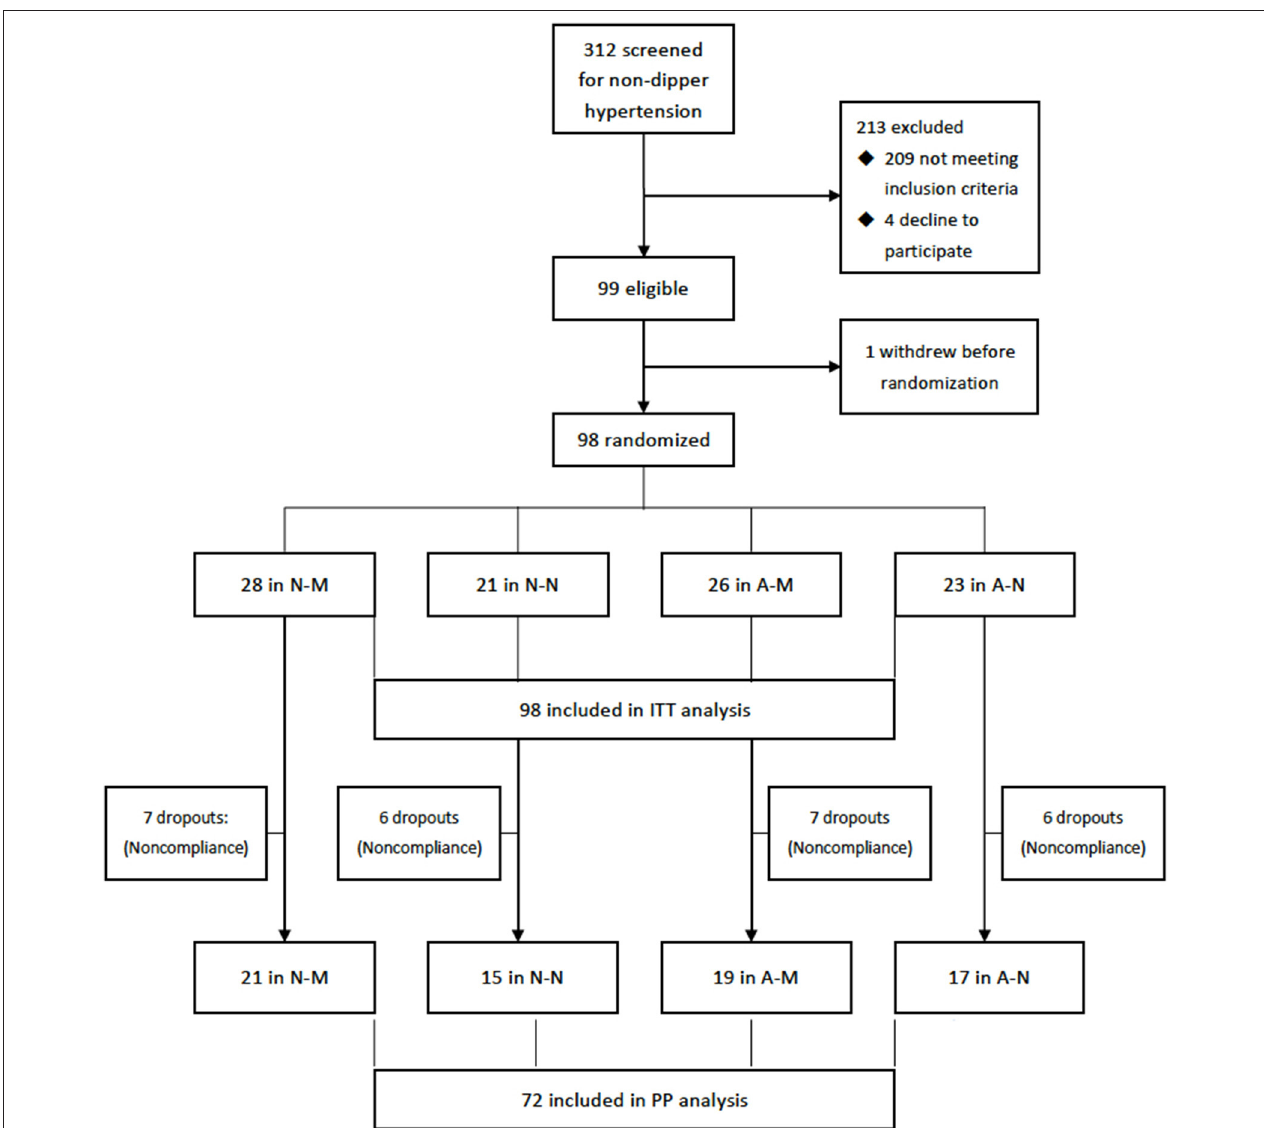
FIGURE 1 | Flowchart of the trail. A-M, amlodipine in the morning; A-N, amlodipine at night; N-M, nifedipine GITS in the morning; N-M, nifedipine GITS at night; GITS, gastrointestinal therapeutic system; ITT, intention-to-treat; PP, per-protocol.